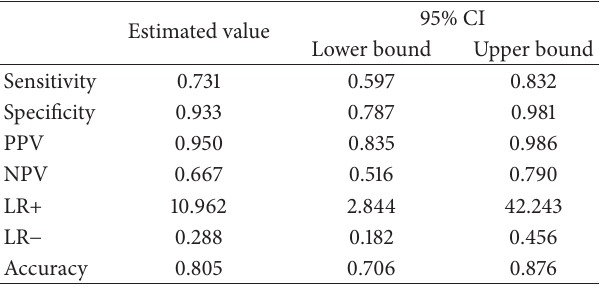
Table 4: Statistical parameters for the best cut-off point of CANO